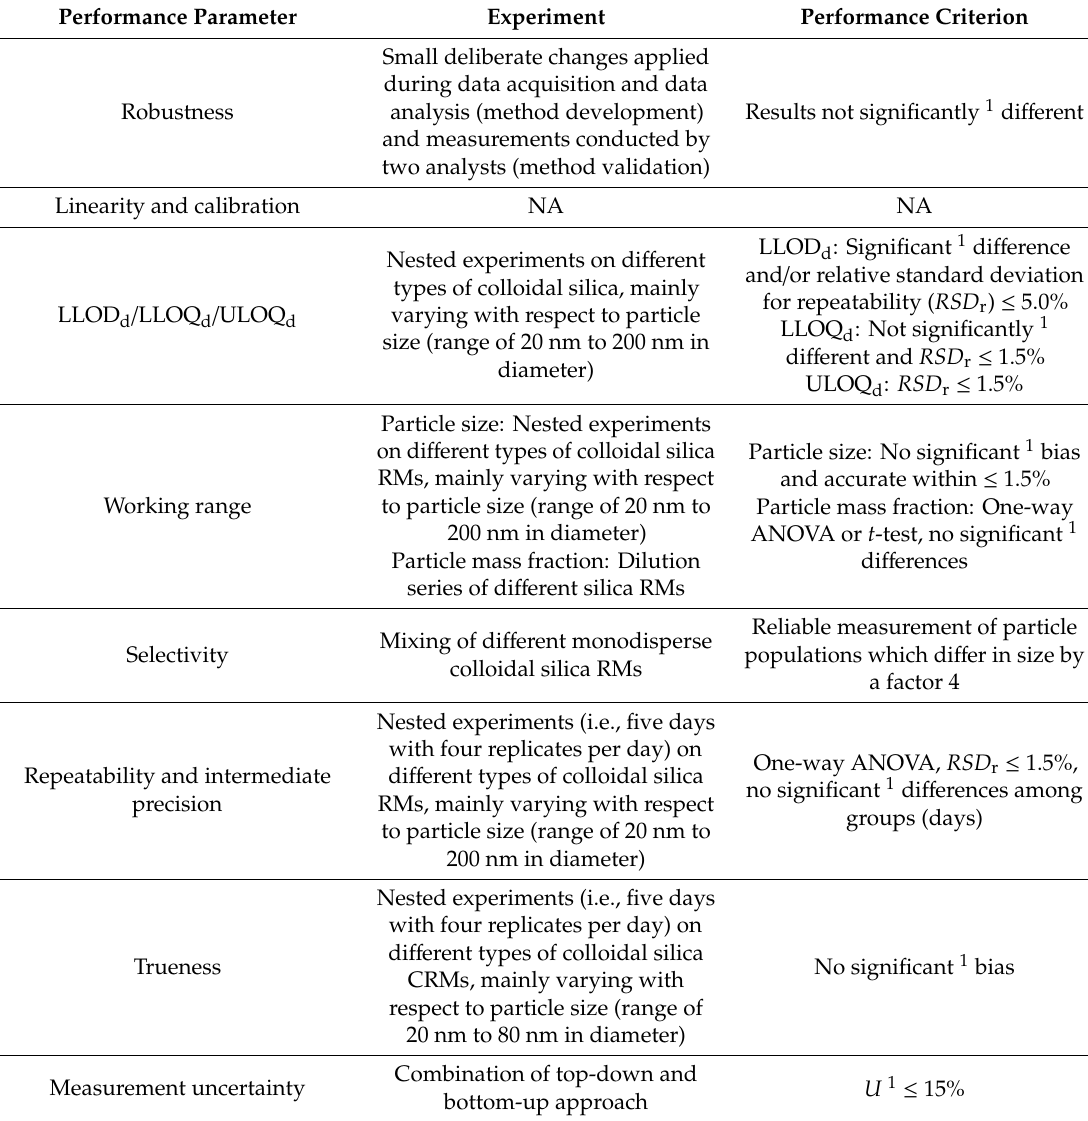
Table A1. Performance parameters and criteria considered during validation